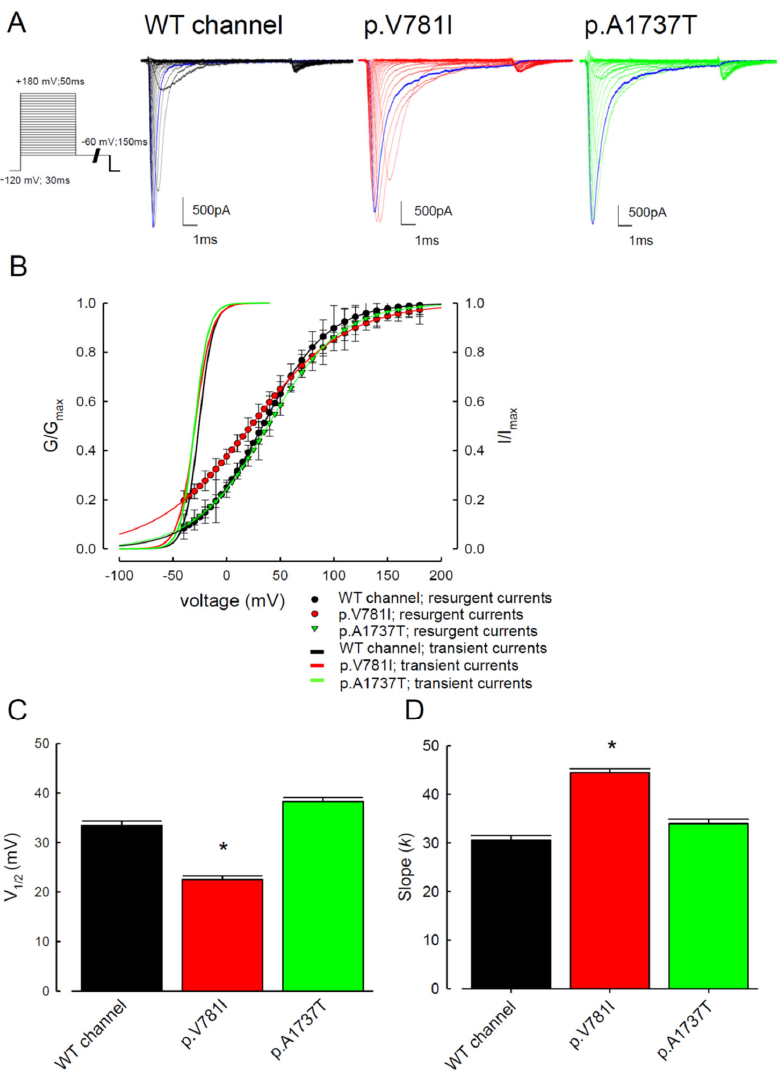
Figure 5. The steady ‐ state activation curve for resurgent Na + currents in the WT and the p.V781I and p.A1737T mutant channels. ( A ) The cells were held at − 120 mV for approximately 30 ms, and then subjected to various 10 ms depolarizing prepulse sampling between − 100 and +180 mV range with stepwise 10 mV increments for about 50 ms. Repolarization pulses evoked the resurgent Na + currents at − 60 mV for approximately 150 ms. We obtained sample sweeps from the WT and the p.V781I and p.A1737T mutant Na v 1.4 channels. The blue traces demonstrate that inactivated currents in the p.V781I and p.A1737T mutant channels were slower than those in the WT channels. ( B ) The steady ‐ state activation curves of the transient (fitted lines in Figure 1B replotted for comparison) and resurgent Na + currents. The resurgent Na + activation curve for each cell was obtained by fitting the data with a Boltzmann function. ( C,D ) The population data ( n = 8) for V h and q . The mean values were 33.4 ± 0.8 mV and 30.6 ± 0.8 for the WT channel, respectively. Those for the p.V781I mutant channel were 22.5 ± 0.7 mV ( n = 8; * p < 0.05) and 44.4 ± 0.9 ( n = 8; * p < 0.05), and those for the p.A1737T mutant channel were 38.27 ± 0.8 mV ( n = 8; * p < 0.05) and 33.9 ± 0.9 (n.s; no significant difference).